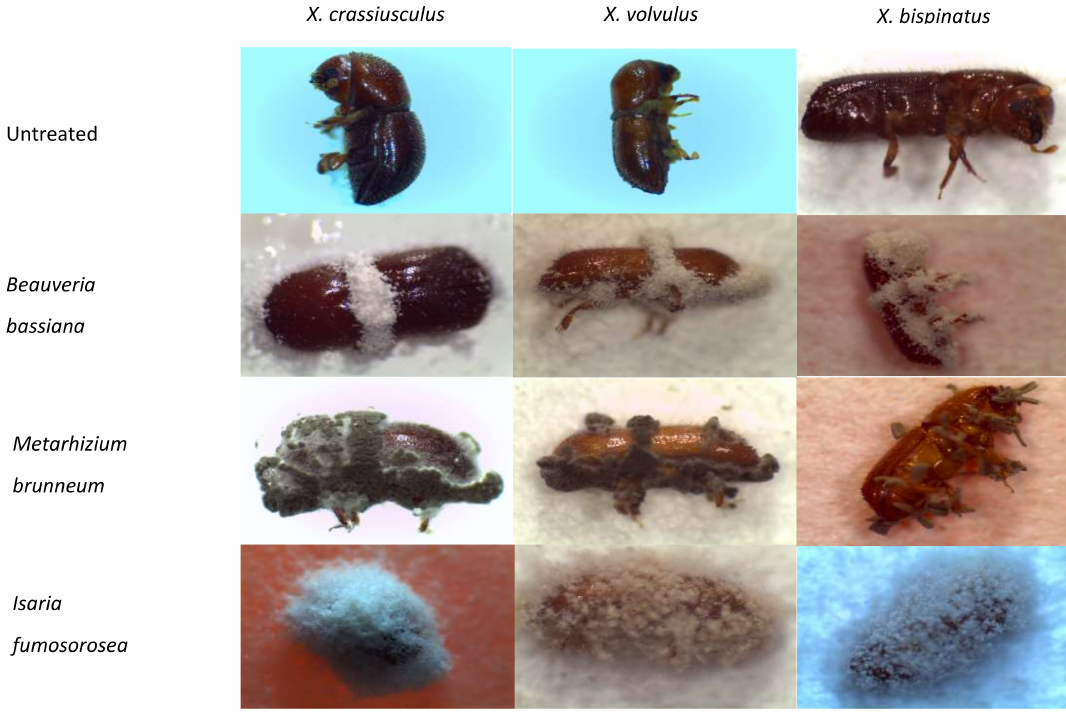
Figure 1. Comparison of untreated and mycosed Xylosandrus crassiusculus , Xyleborus volvulus and Xyleborus bispinatus after exposure to a filter paper disk inoculated with fungal suspensions (2.4 × 10 6 spores/mL) of either Beauveria bassiana (BotaniGard ES), Metarhizium brunneum (Met52 EC), or Isaria fumosorosea (PFR-97 20% WDG). Untreated = control disks with distilled water only. Fungal phenotype post-mortem for mycosed beetles: Beauveria bassiana with white spores; Metarhizium brunneum with green spores; Isaria fumosorosea with white to greyish mauve